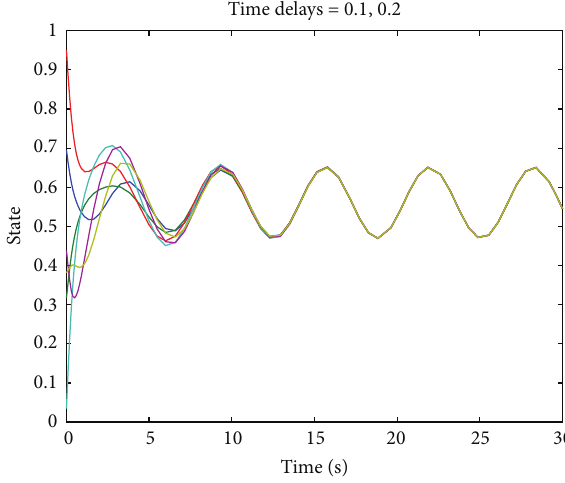
Figure 4: State trajectory of system (7) with G = G 𝑐 and given